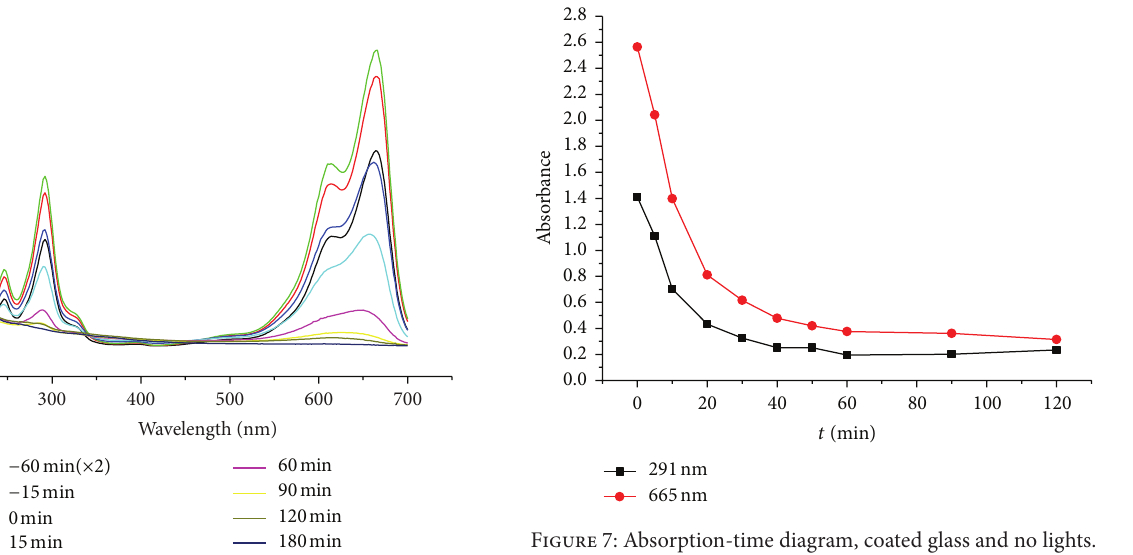
Figure 7: Absorption-time diagram, coated glass and no lights.